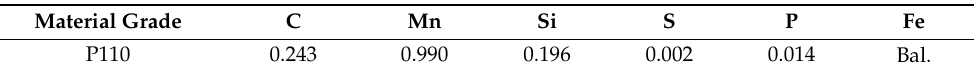
Table 11. Chemical composition of the P110 pipeline steel (wt.%) [16]. Reprinted with permission from [16], 2019, Elsevier.